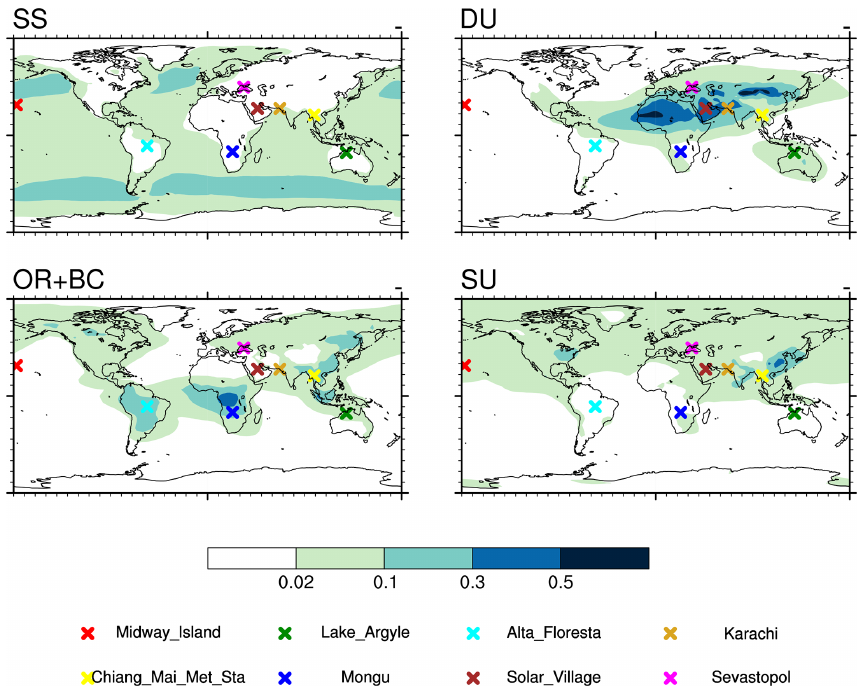
Figure 6. Locations of the AERONET sites used in the analysis. The shading shows the annual mean AOT of the five CAMS aerosol species sea salt (SS), mineral dust (DU), organic matter (OR), black carbon (BC) and sulfates